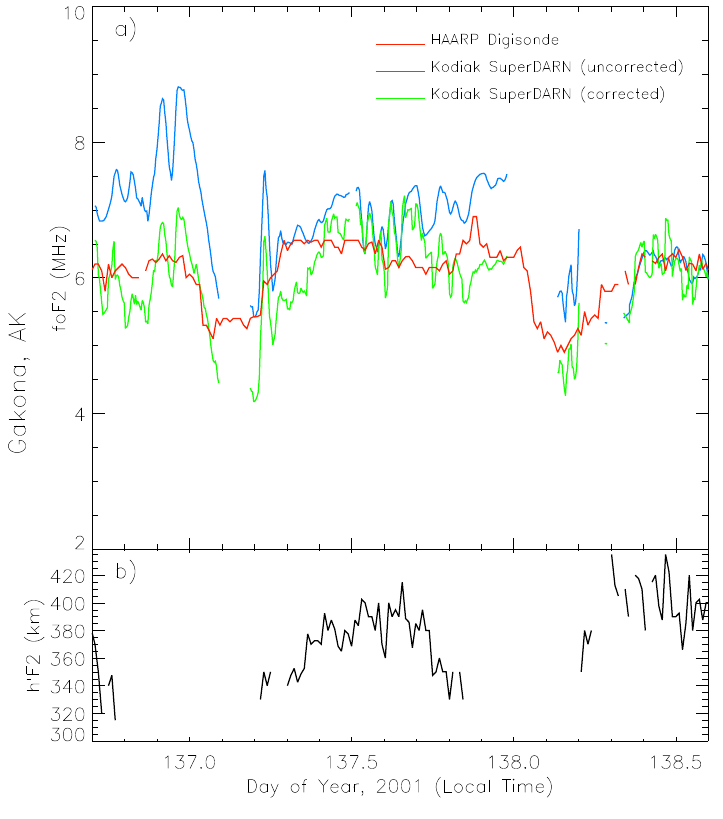
Fig. 6. (a) Critical frequencies near Gakona, Alaska measured with the HAARP digisonde (in red) and es- timated from real-time SuperDARN ground-scatter data (in blue). The green curve shows the SuperDARN results af- ter applying a correction for the varia- tion in critical frequency with the vir- tual height of the F-region peak. (b) F- region virtual heights observed with the HAARP